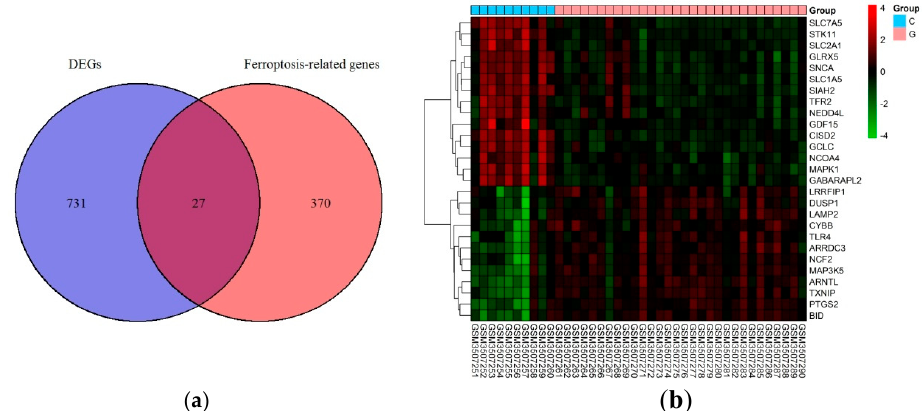
Figure 1. Ferroptosis-related differentially expressed genes in GIONFH and non-GIONFH samples. ( a ) Venn diagram of ferroptosis-related differentially expressed genes after the intersection between differentially expressed genes and ferroptosis-related genes. ( b ) Heatmap of the 27 ferroptosis-related differentially expressed genes in GIONFH and non-GIONFH samples.